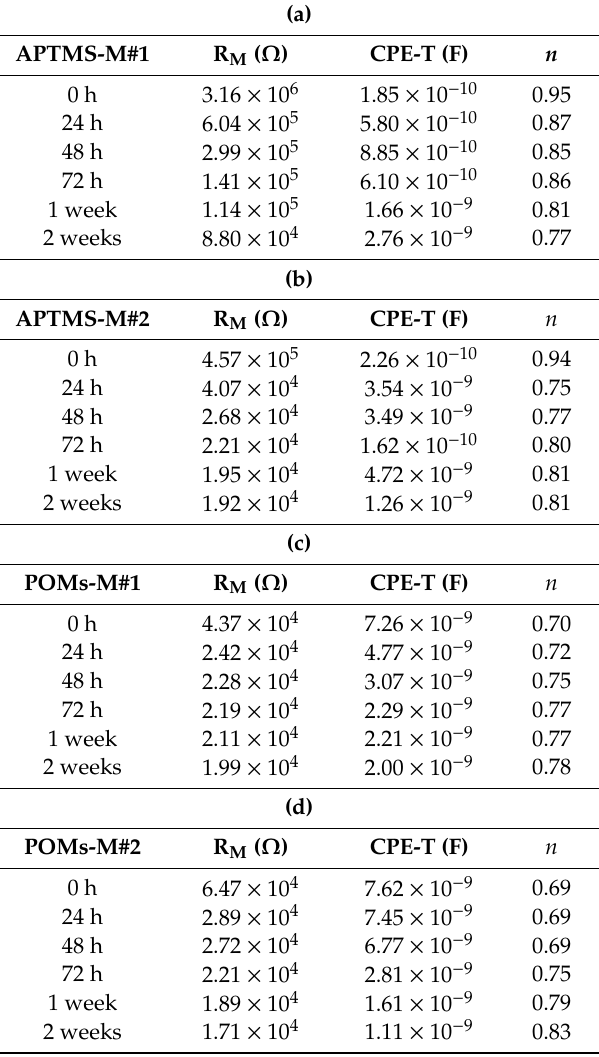
Figure 11. The equivalent circuit of the system. Table 2. The fitted values for ( a ) APTMS-M#1, ( b ) APTMS-M#2, ( c ) POMs-M#1, and ( d ) POMs-M#2.